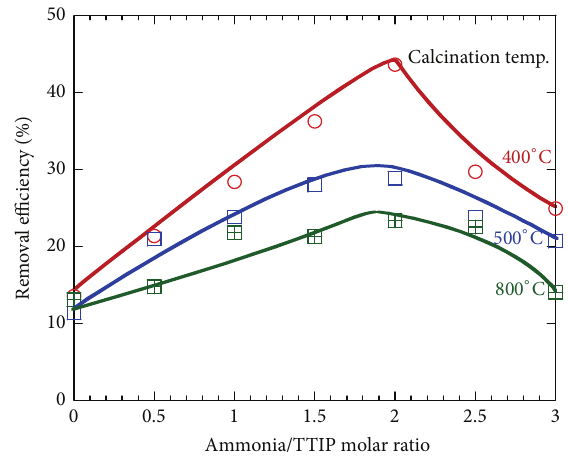
Figure 8: The removal efficiency of ethylene photooxidation over N-TiO 2 as function of the various ammonia/TTIP molar